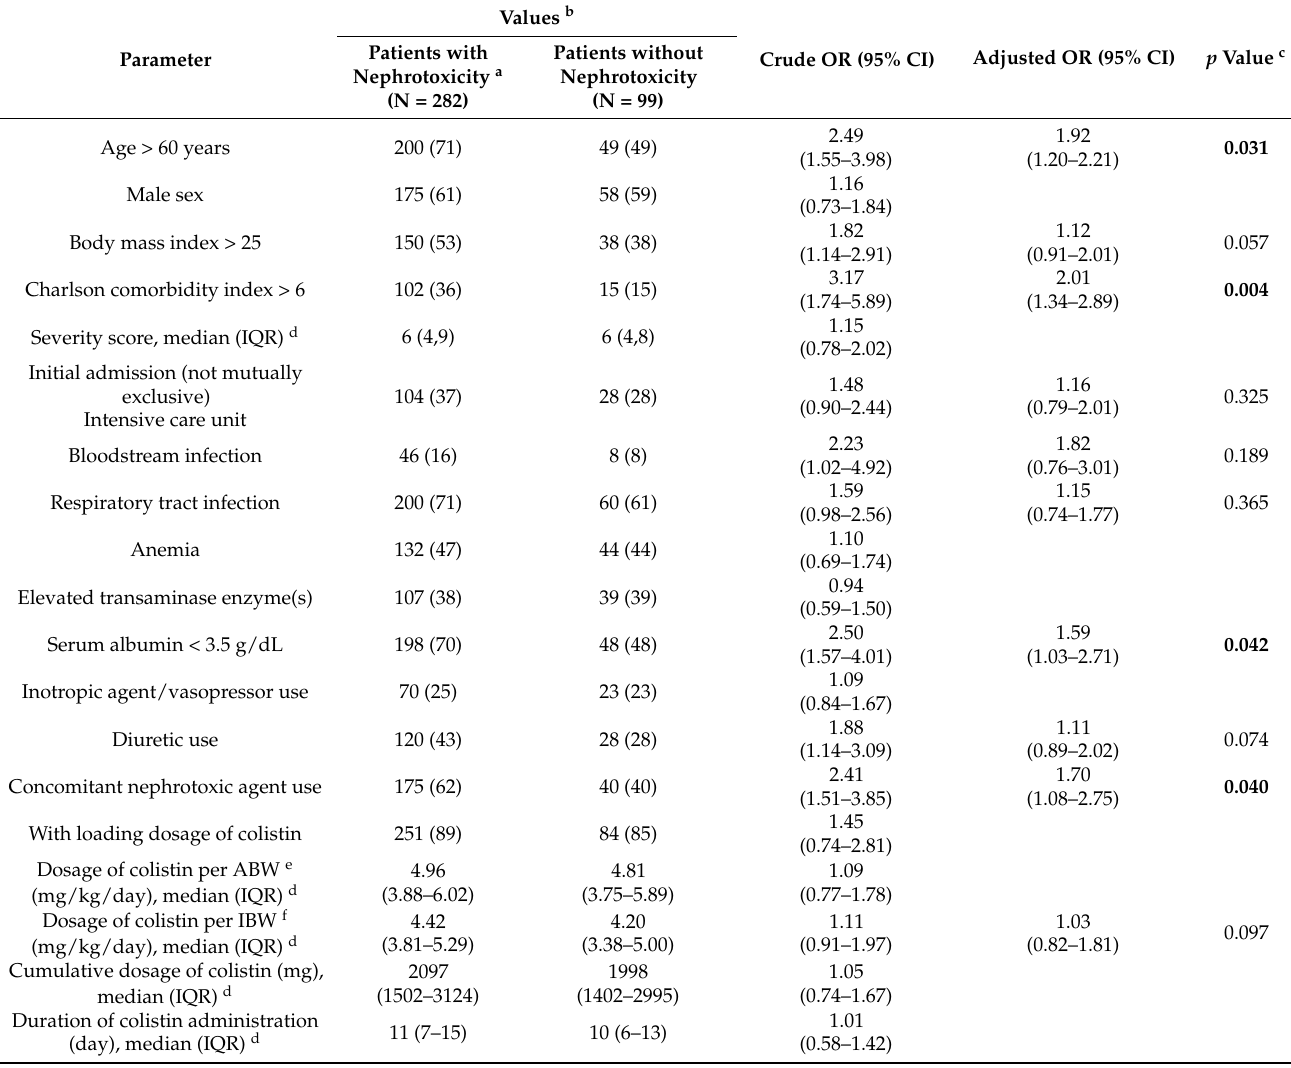
Table 4. Factors influencing nephrotoxicity among the patients receiving intravenous colistin.